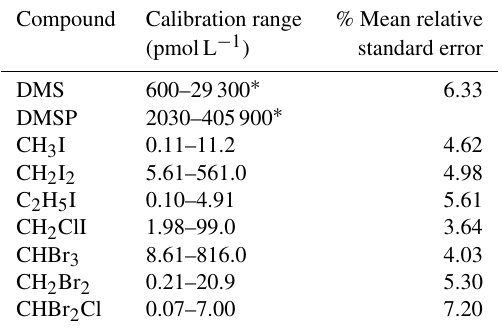
Table 2. Calibration ranges and calculated percentage mean relative standard error for the trace gases measured in the